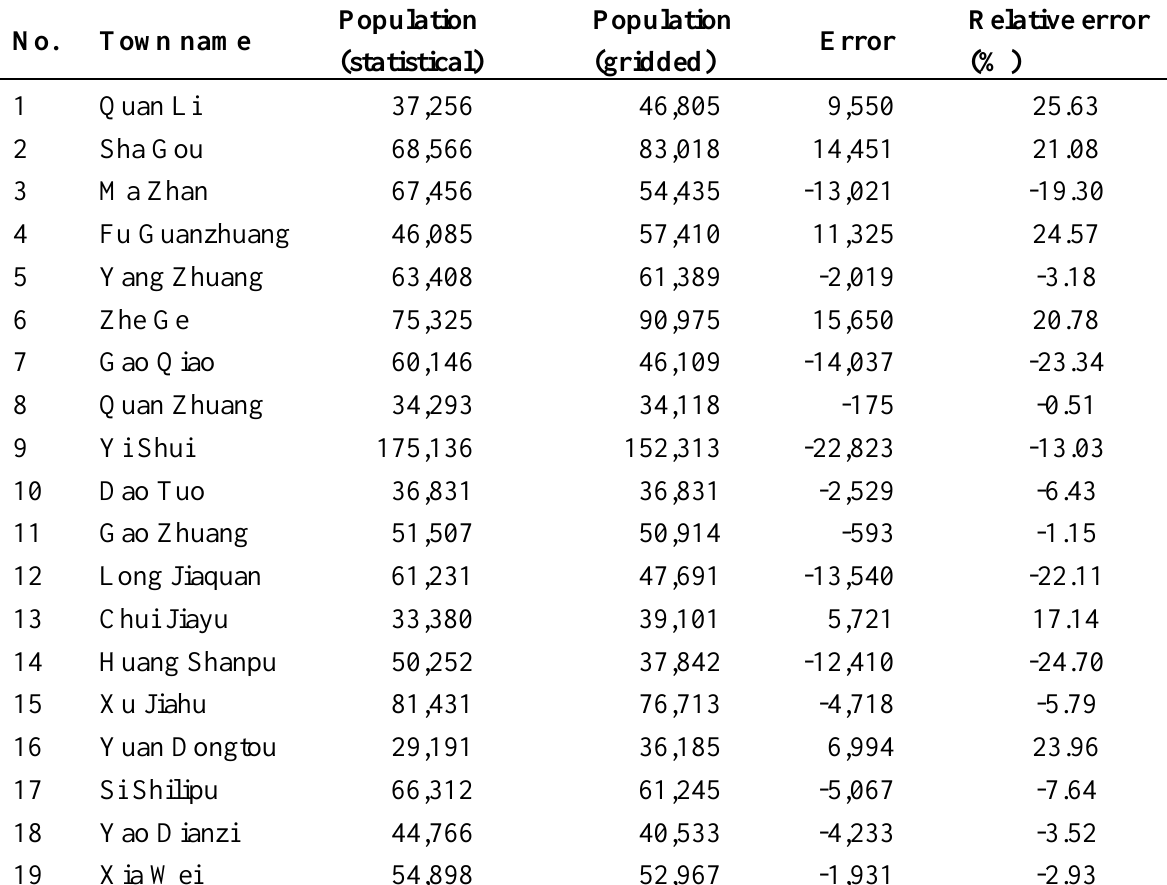
Table 2. Results validation with census data of 19 sample towns in Yishui